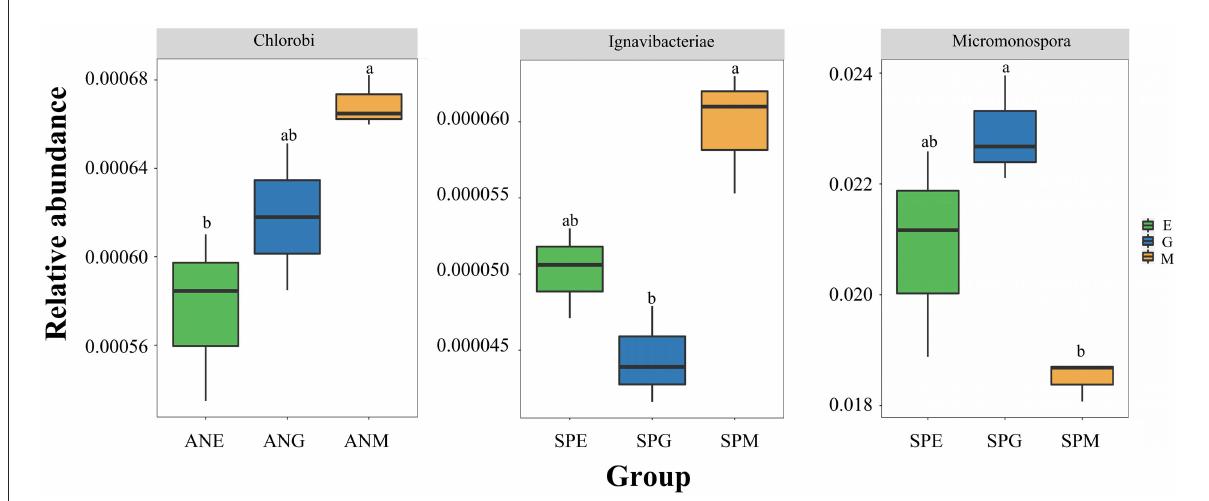
FIGURE3 Pairwise comparison of different rhizosphere soil bacteria at phylum and genus levels in each group. Different lowercase letters indicate that the relative abundance of rhizosphere bacteria of the same plant is significantly different ( P < 0.05) under different utilization patterns.